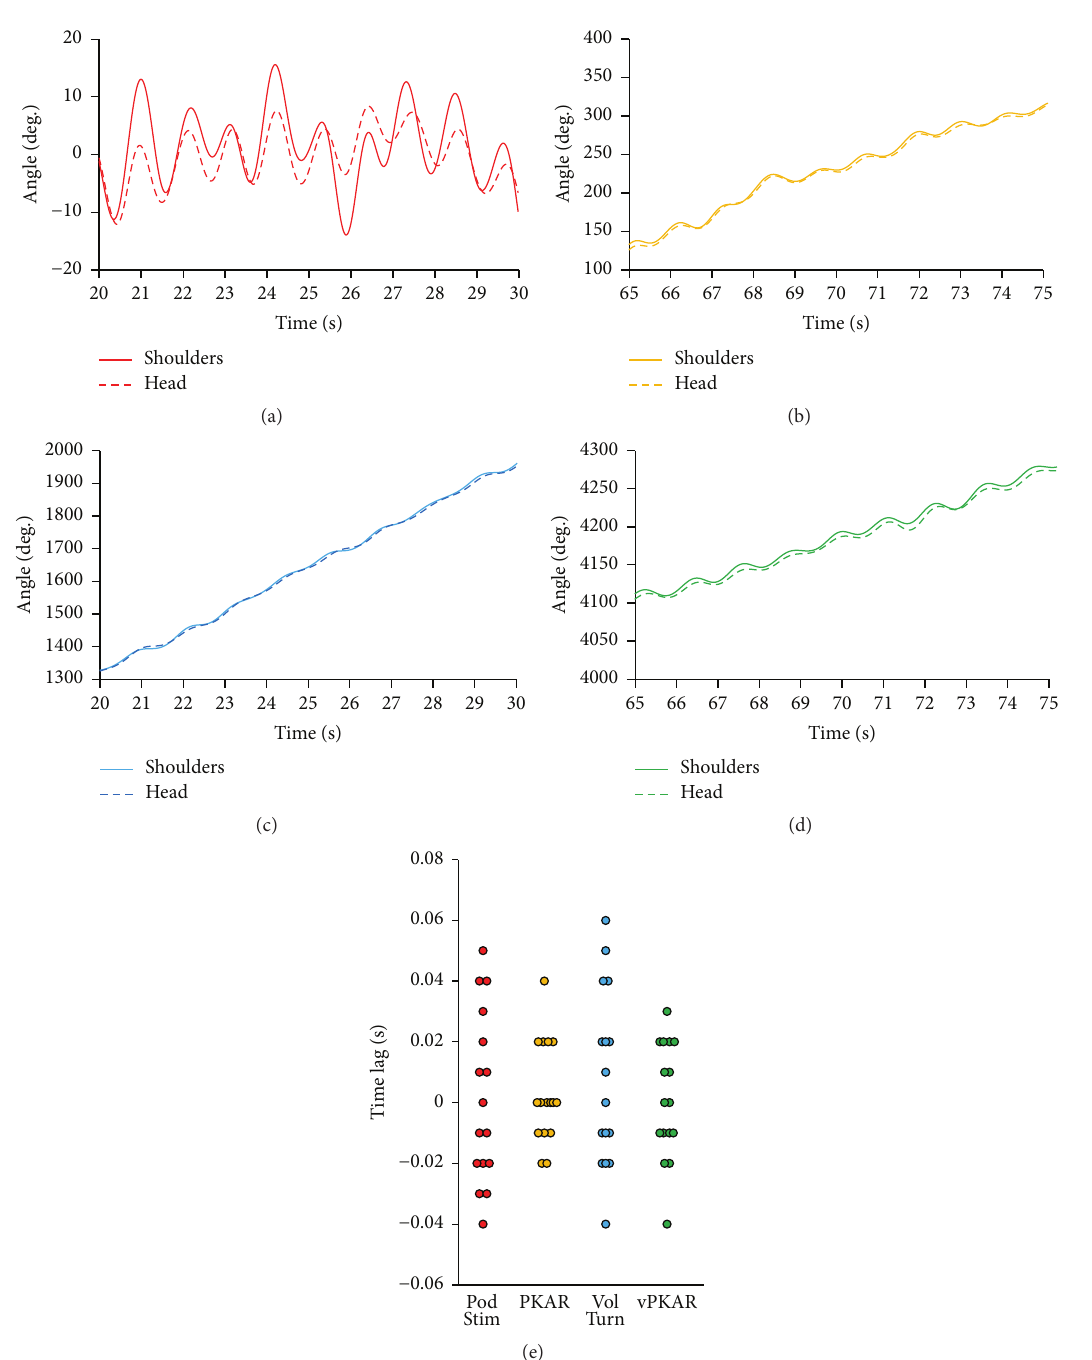
Figure 3: Coordinated head and shoulder movements. Angle described by the head (solid lines) and shoulders (dashed lines) mediolateral axis in a time period of 10 s during podokinetic stimulation (Pod Stim, (a)), PKAR (b), voluntary turning (Vol Turn, (c)), and its posteffect (vPKAR,(d)).Duringplatformrotation,thebodywaskeptalmostfixedinspacewhileheadandshouldersshowedminorleftandrightangular shifts. During voluntary turning (c) and during the two posteffects (b and d), head and shoulders continued to rotate in the horizontal plane, so that, in addition to their left and right yaw shift (a), the angle described by these segments continued to increase over time. The large differences in the y -scale amplitude between panel (a) and panels (b), (c), and (d) accommodate for the differences in the cumulative angle. The time lags between head and shoulders traces are reported in panel (e) for each subject. The 10ms interval between the data points depends on the acquisition frequency; in many cases, several points coincide. There were no obvious differences across